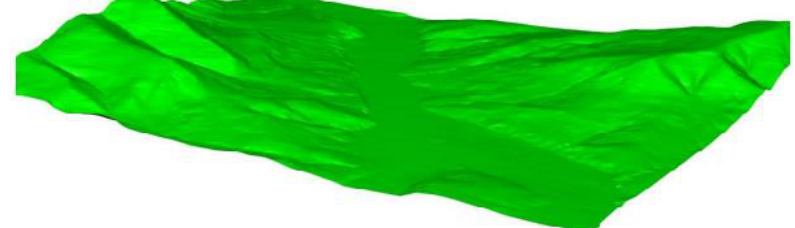
Figure 17. Digital terrain model—view from the side of Mszana Dolna, Phong type rendering.